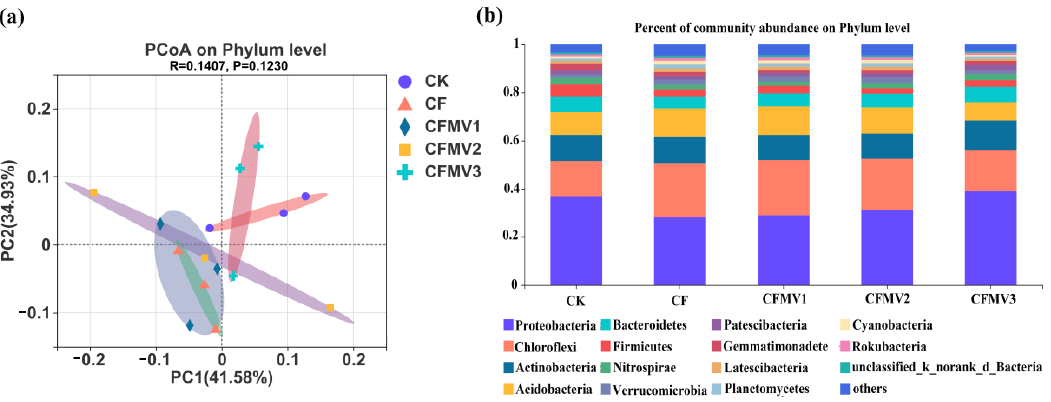
Figure 2. Principal component analysis ( a ) and bacteria community abundance ( b ) on phylum level during the different treatments.